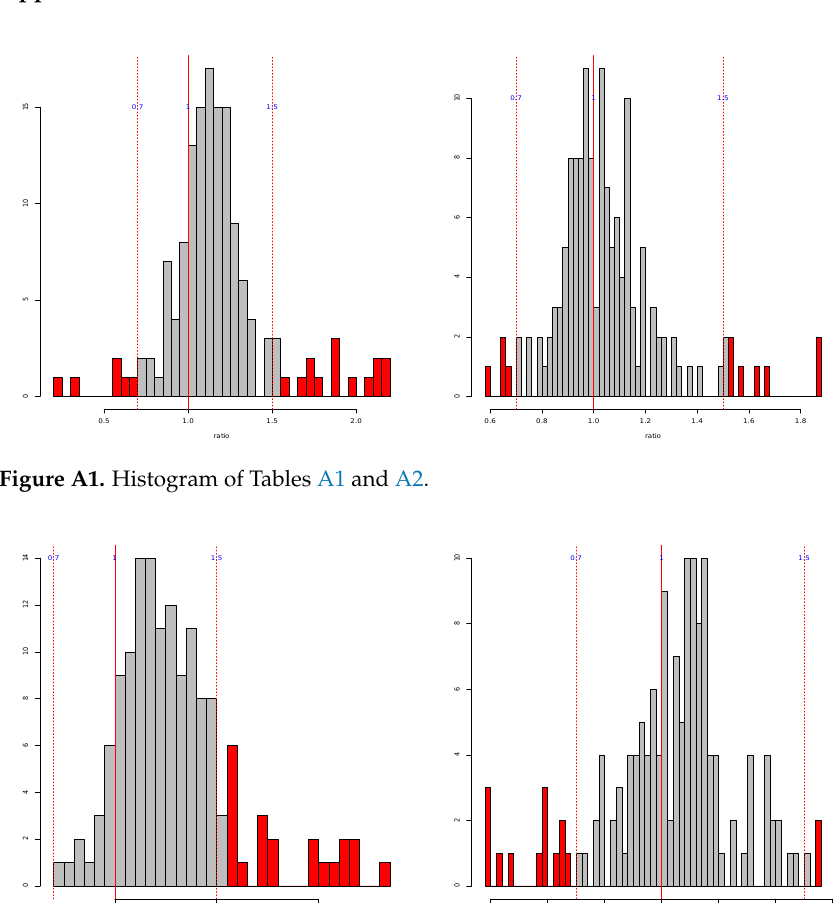
ratio1.0 1.5 Figure A2. Histogram of Tables A3 and